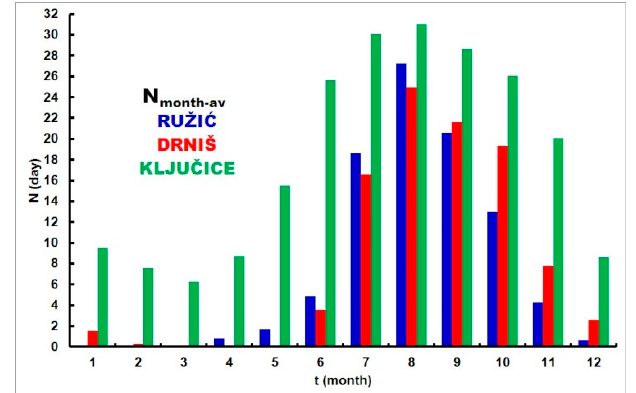
Figure 7. Average monthly discharges measured at the three hydrological stations along the Č ikola River course over the period 1987–2017 (missing 1991–2002, 2008).